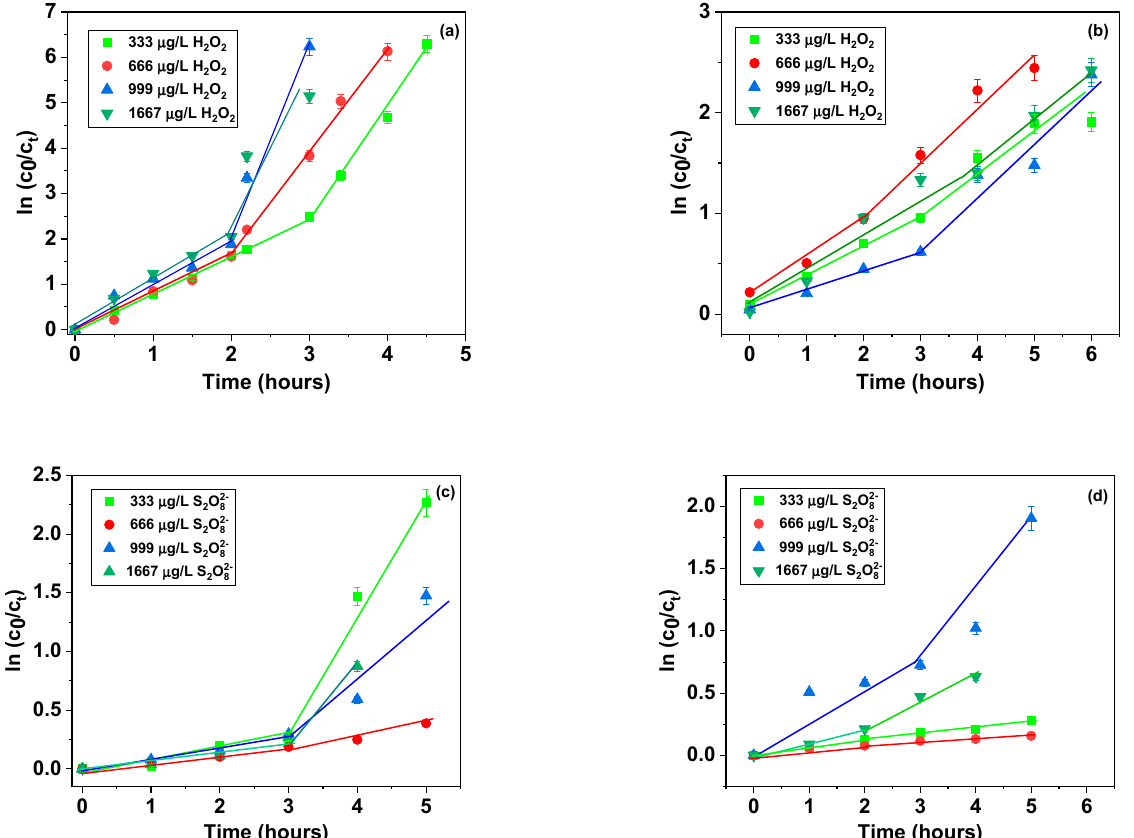
Figure 3. Pseudo-first order kinetic of photodegradation for ( a ): MB in the presence of H 2 O 2 ; ( b ): MO in the presence of H 2 O 2 ; ( c ): MB in the presence of S 2 O 82 − ; ( d ): MO in the presence of S 2 O 82 − . ters for this model (including the correlation coefficients, R 2 ) are depicted in Tables 1 and 2. Table 1. Rate constants of the photo-Fenton process as a function of H 2 O 2 concentration. Kinetic Data for MB Kinetic Data for MO cH 2 O 2 ( µ g/L)